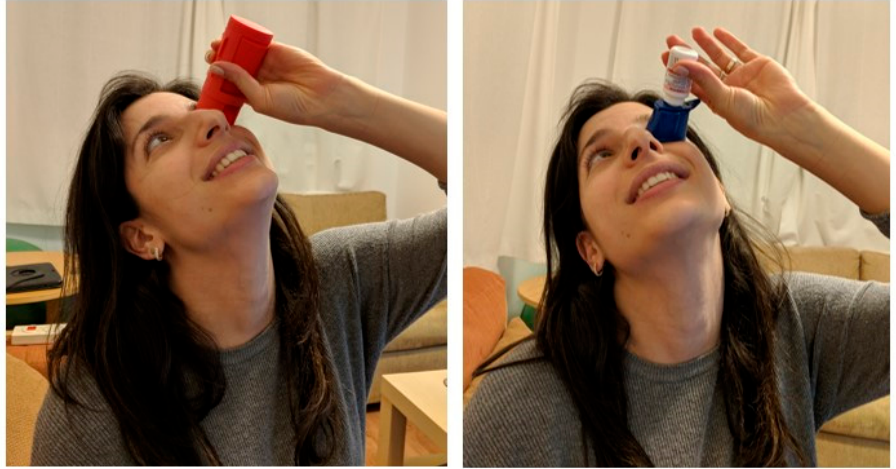
Figure 1. Devices evaluated in the study. ( Left ): Opticare, ( Right ): Autodrop.